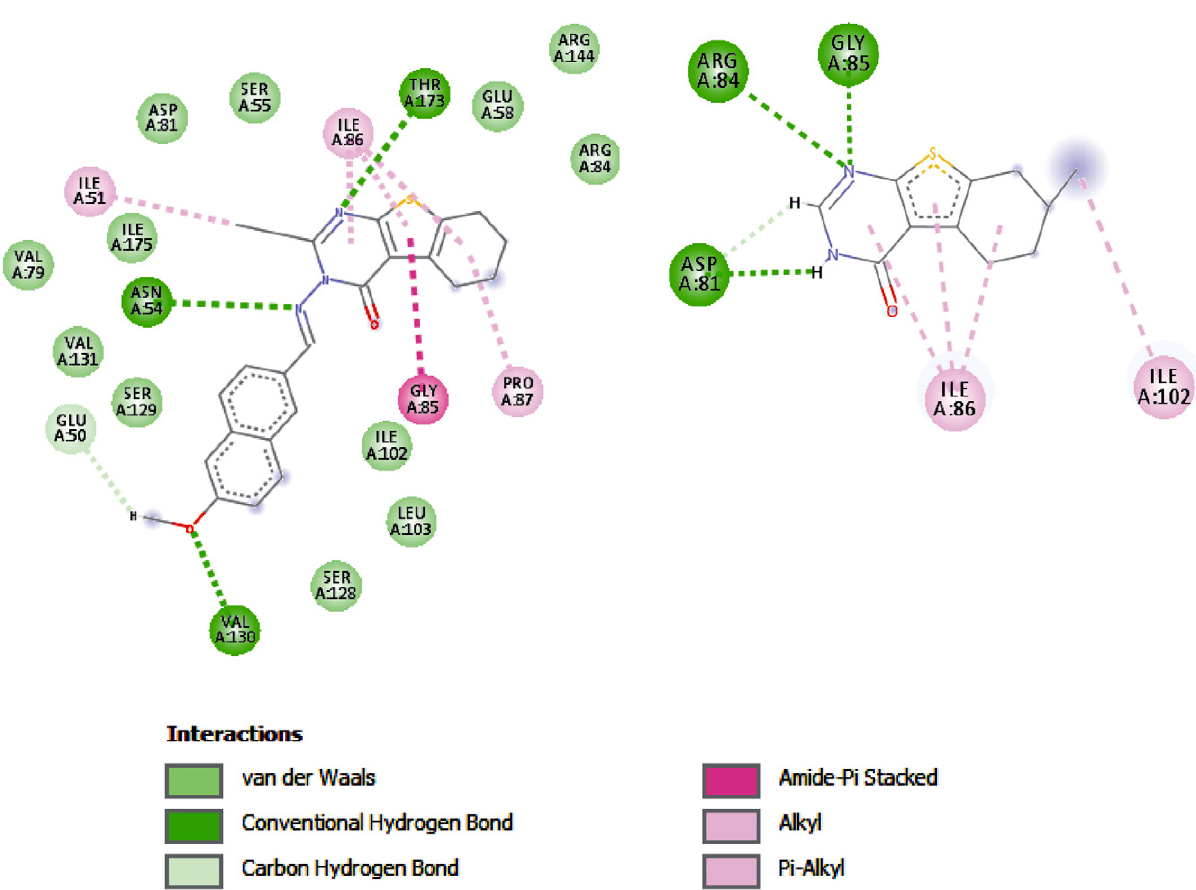
Fig. 7. Two-dimensional depiction of the docked conformations of Ligand 13 and ligand 1 with enzyme DNA gyrase